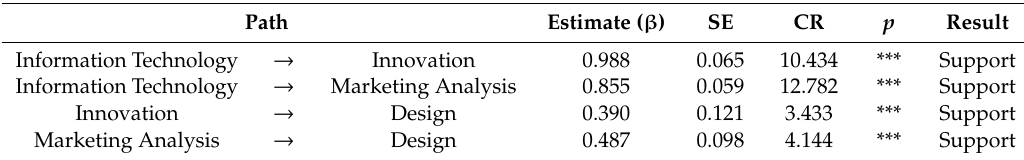
Table 3. Summary of hypotheses testing results.